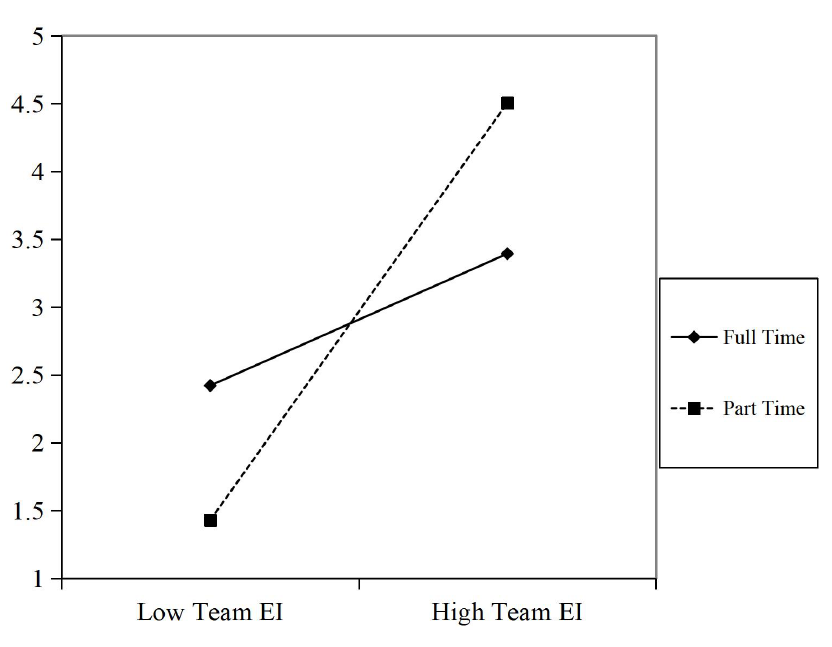
Fig. 2: Moderating effect of Work